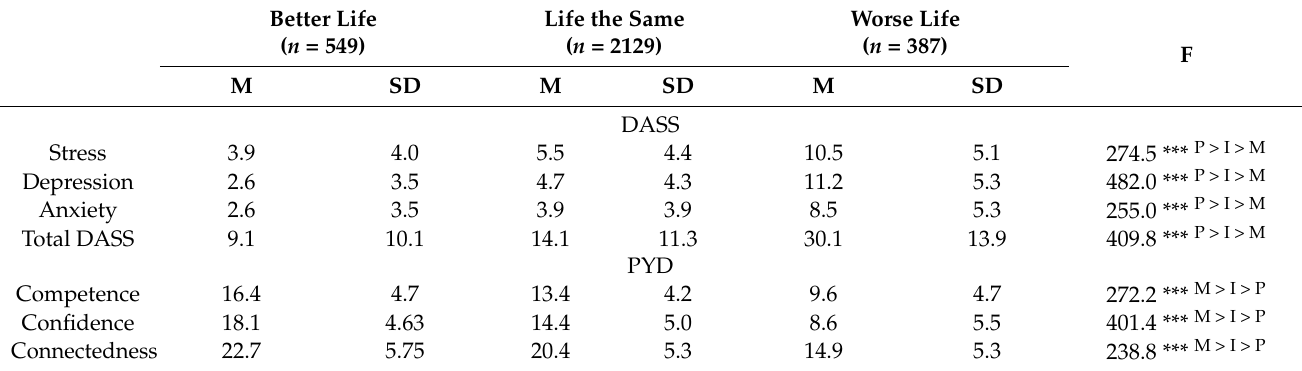
Table 7. Comparisons between groups, according to the assessment of current life in lower secondary and upper secondary school